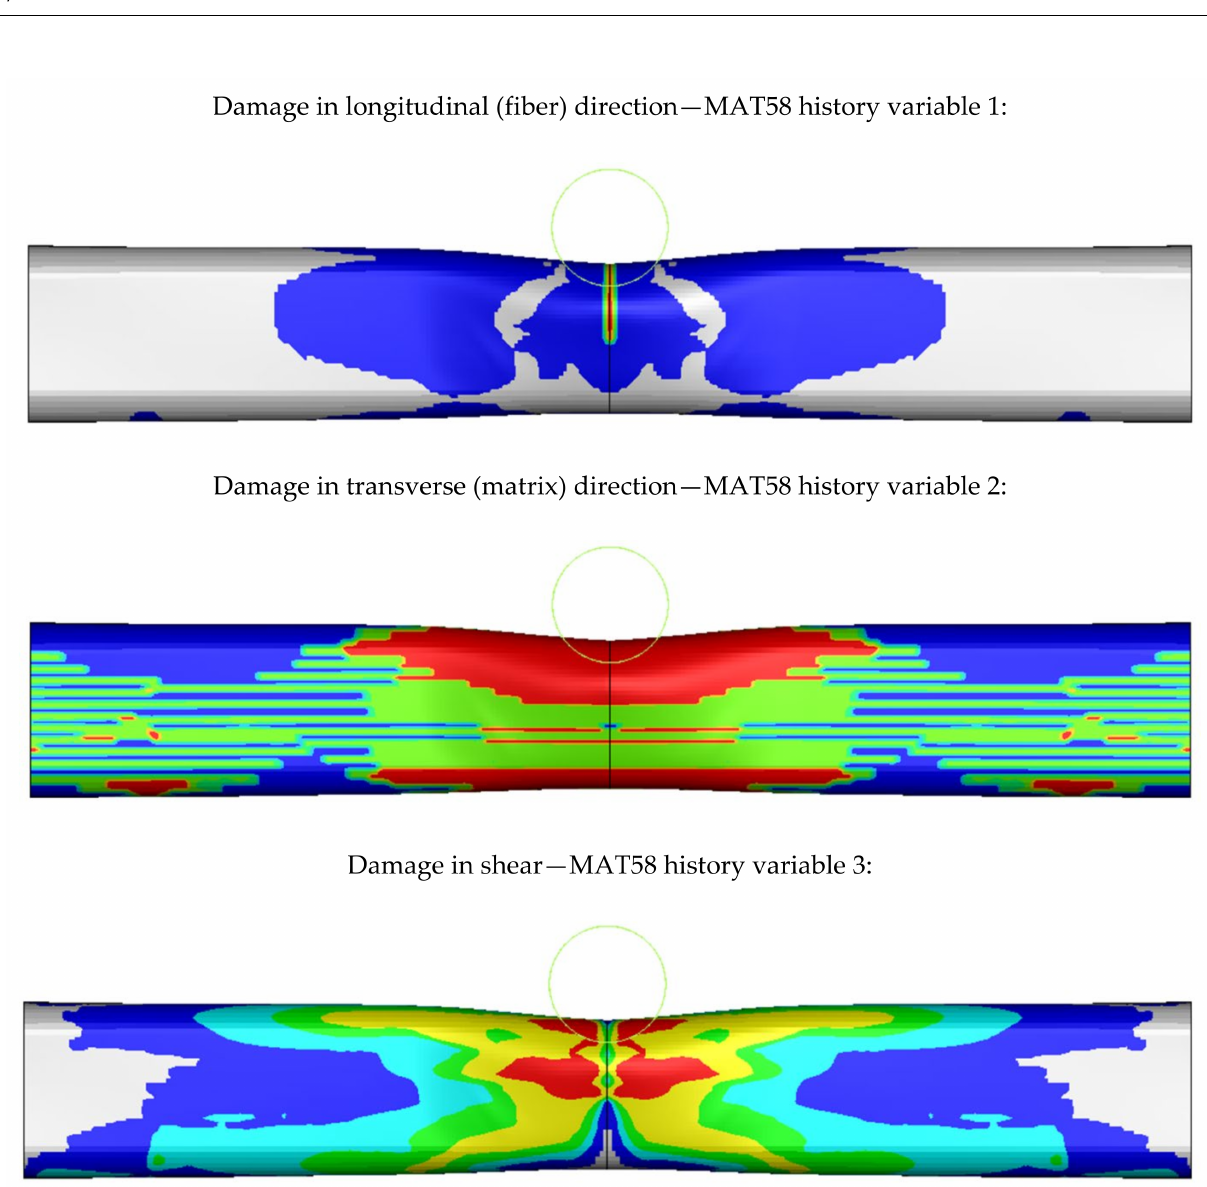
Figure 9. MAT58 predicted damage in the outer layer of the [0 4 , 90 3 ] S specimen (color scheme: gray—not damaged, red—fully damaged; indenter shown for scale representation